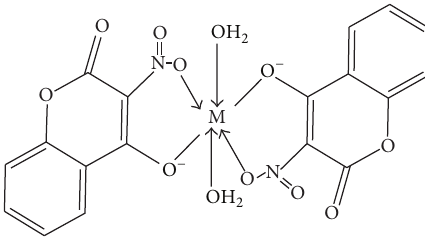
Figure 2: Proposed structure for compounds 1 and 2 .